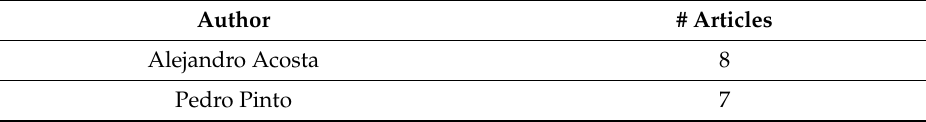
Table 12. Top 10 articles with more tag